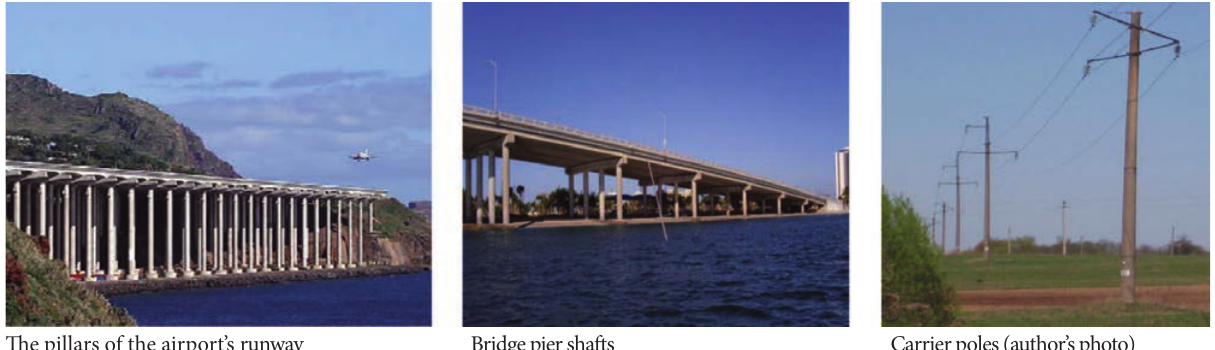
Fig. 1. Modelling of annular cross-section for reinforcement concrete elements